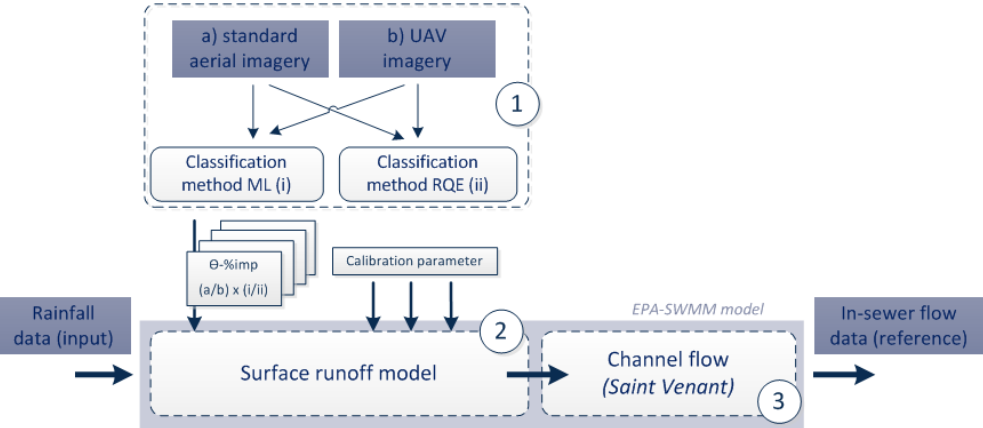
Figure 1. Overall analysis approach ( (cid:9) -%imp: model parameter “degree of imperviousness”; ML: maximum likelihood; RQE: boosting with randomized quasi-exhaustive feature